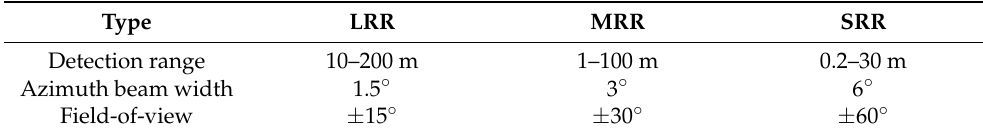
Field-of-view ± 15 ◦ ± 30 ◦ ± 60